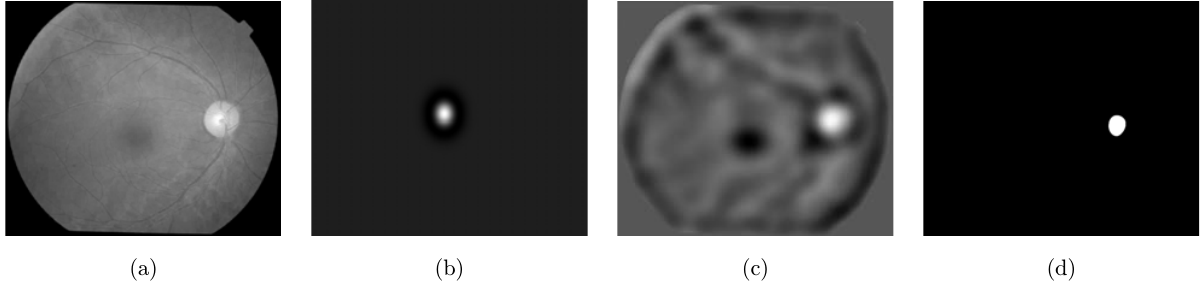
Fig. 5. OD detection. (a) Red channel of OD, (b) LoG ¯lter, (c) Enhanced OD region and (d) Binary OD region.